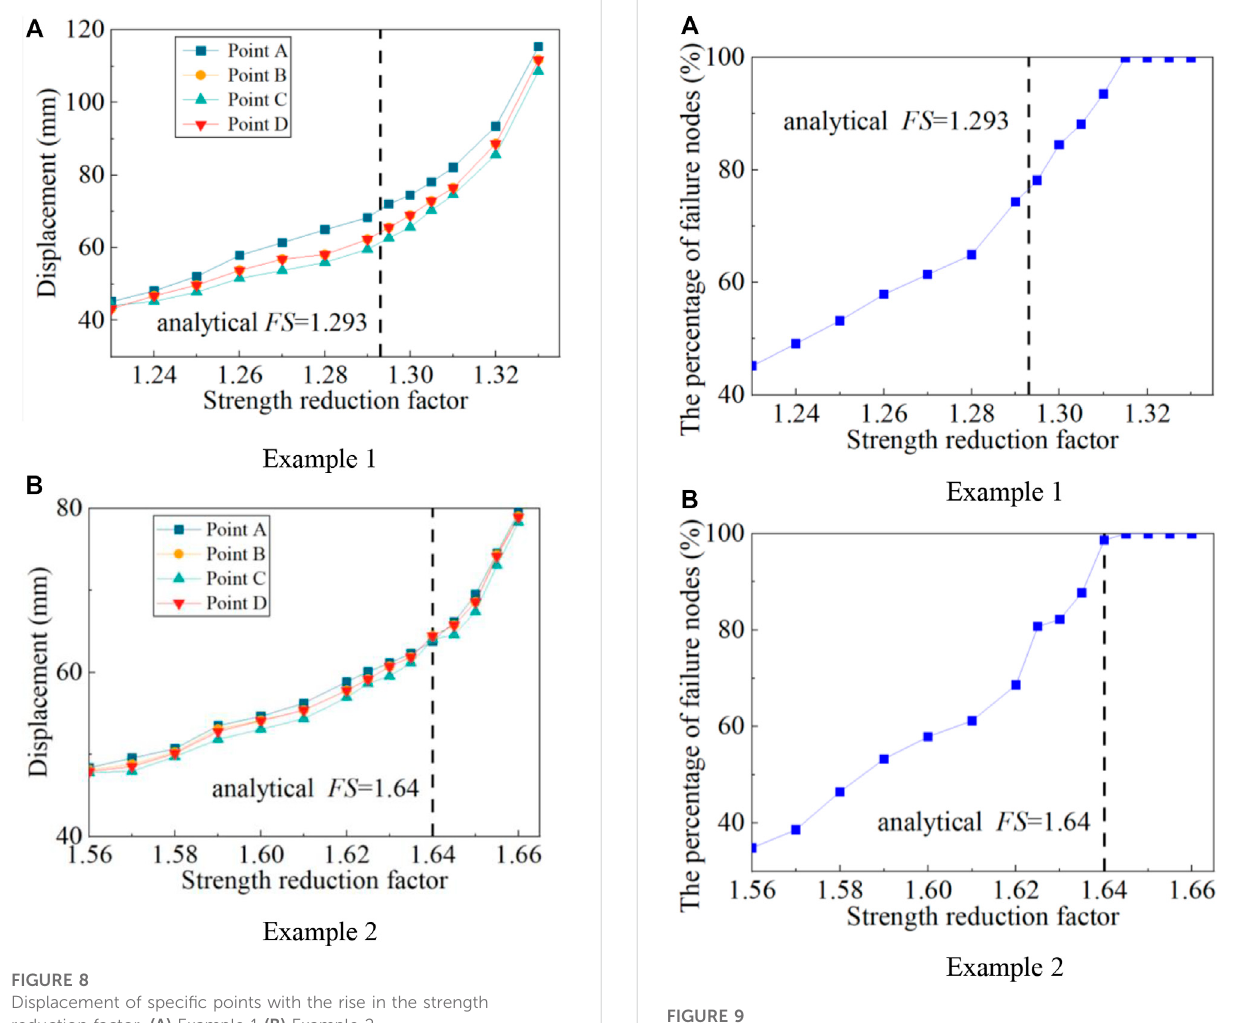
Percentage of failure nodes with the increase in the strength reduction factor. (A) Example 1 (B) Example